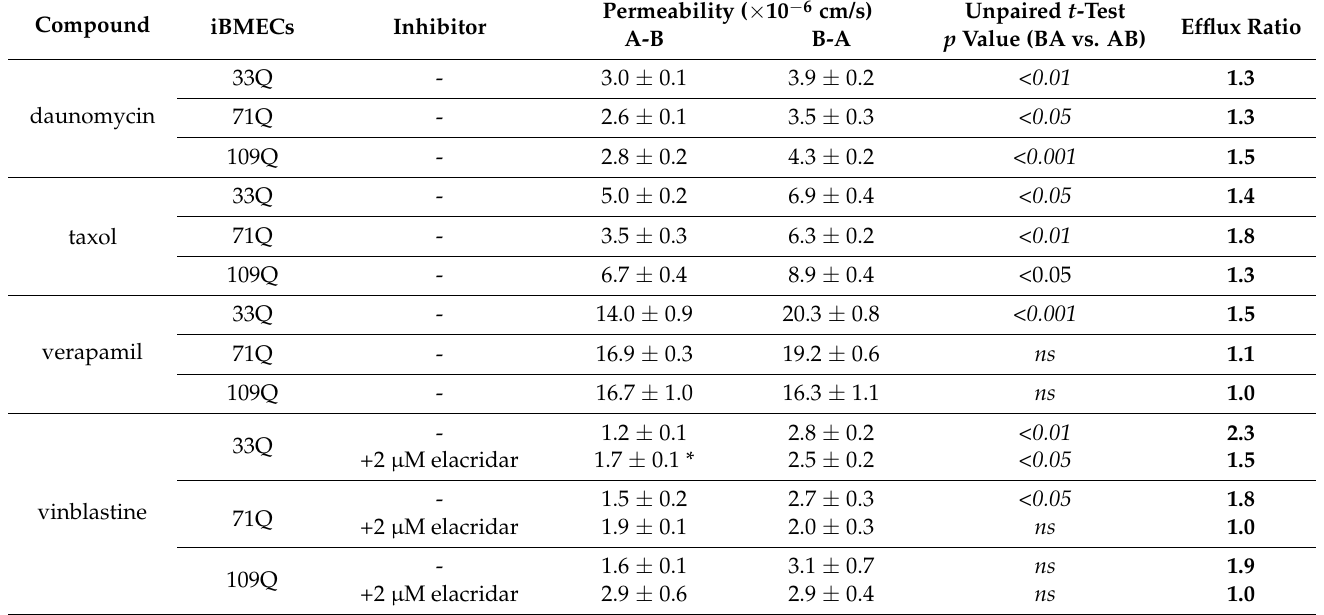
Table 2. Polarized transport in